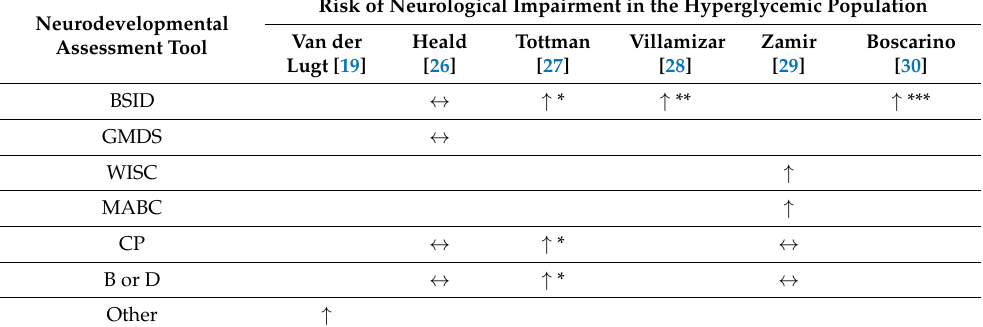
Table 2. Neurodevelopment